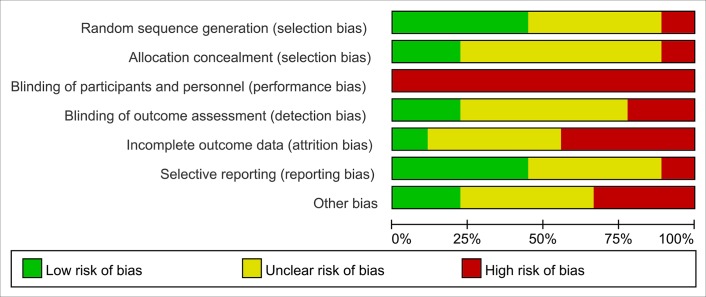
Risk of bias graph.